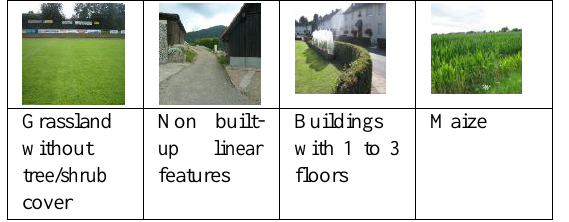
Table 2: Example of land use land cover categories of LUCAS data